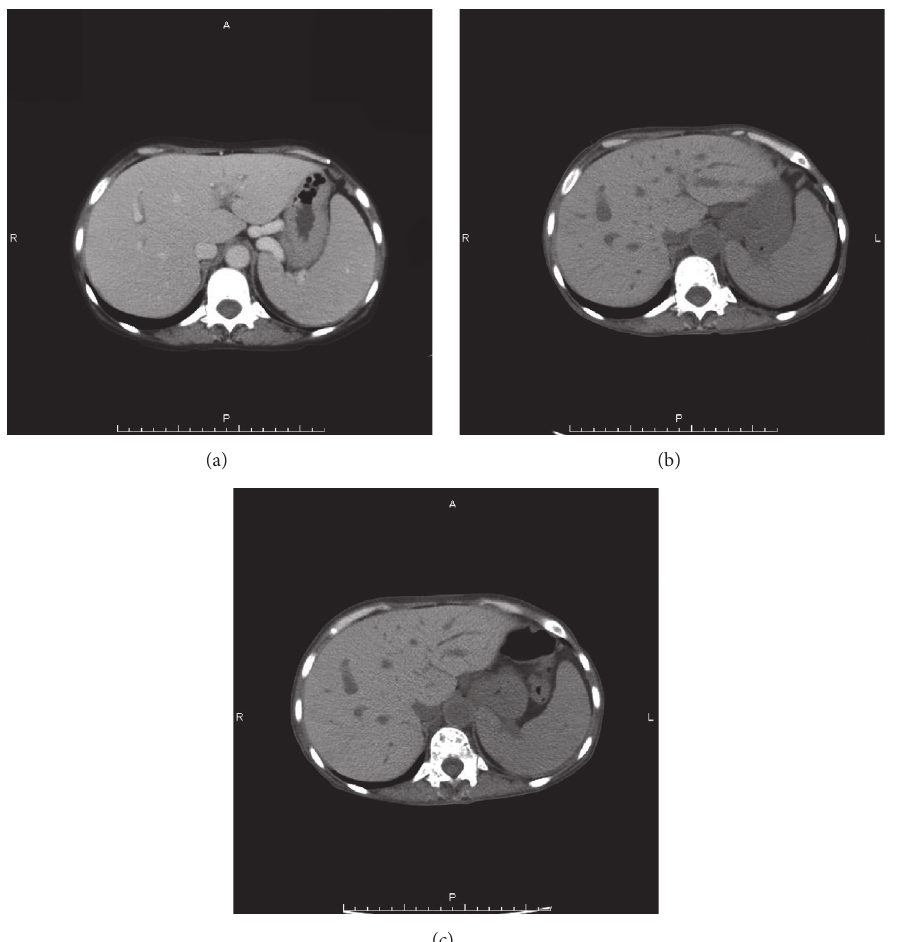
Figure 3: Case 2. CT. (a) Before HCT, the CT showed severe splenomegaly. (b, c) After HCT, the massive splenomegaly was reduced. (b) Three months. (c) Six months.